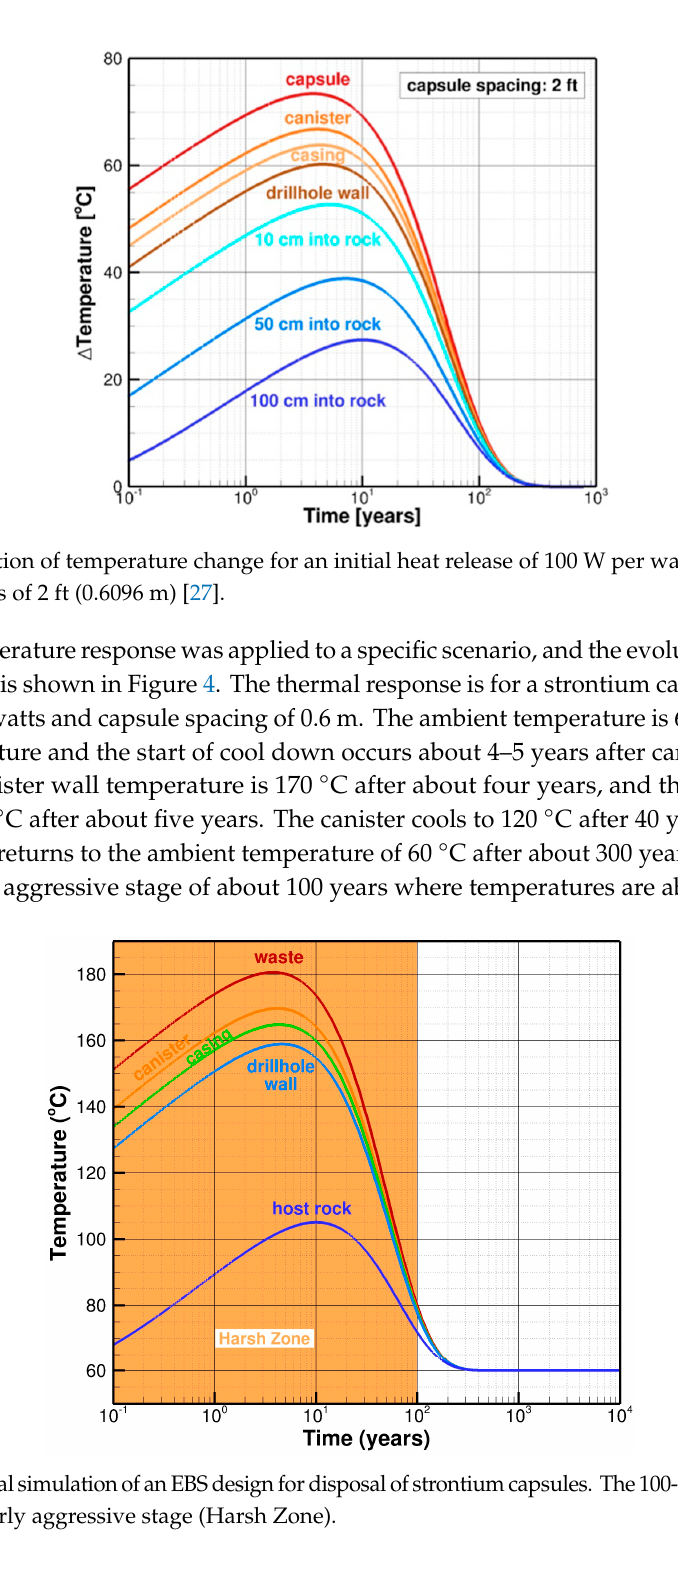
Figure 4. ThermalsimulationofanEBSdesignfordisposalofstrontiumcapsules. The100-yeardemarcation Figure 4. Thermal simulation of an EBS design for disposal of strontium capsules. The 100-year highlights an early aggressive stage (Harsh demarcation highlights an early aggressive stage (Harsh Zone).